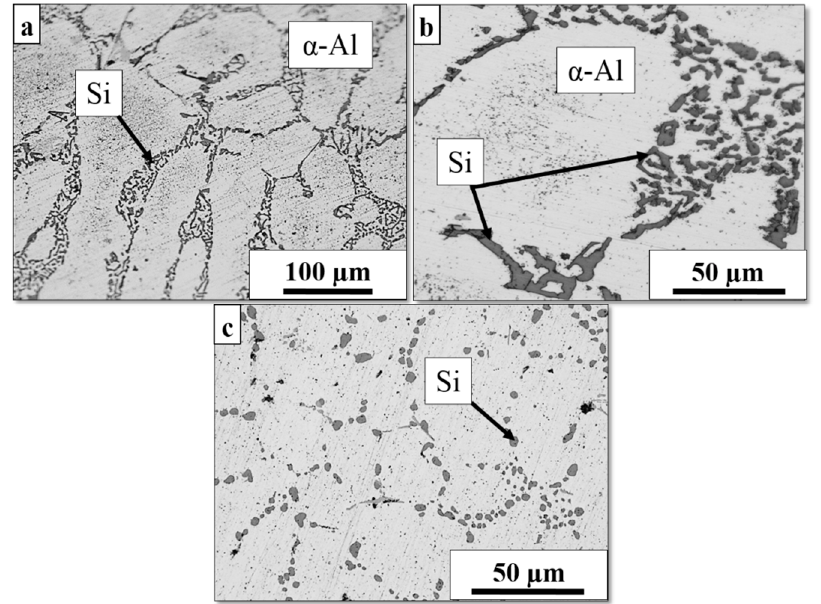
Figure 2. Microstructural features of the A356 Al alloy of ( a ) as-cast, ( b ) enlargement of eutectic Si and ( c ) eutectic Si after T6.